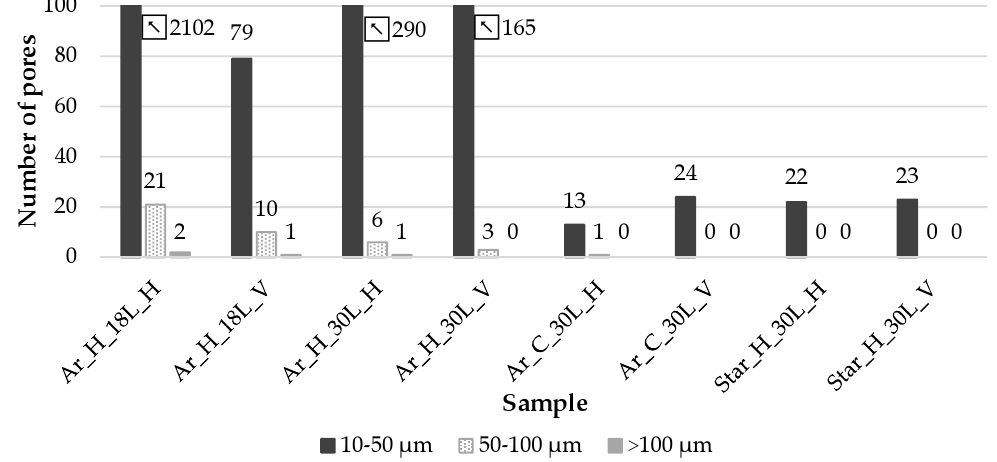
Figure 15. Porosity histogram of WAAM walls manufactured for testing of mechanical properties. Naming sequence: Shielding gas_Deposition strategy_Gas flow rate_Specimen testing direction.